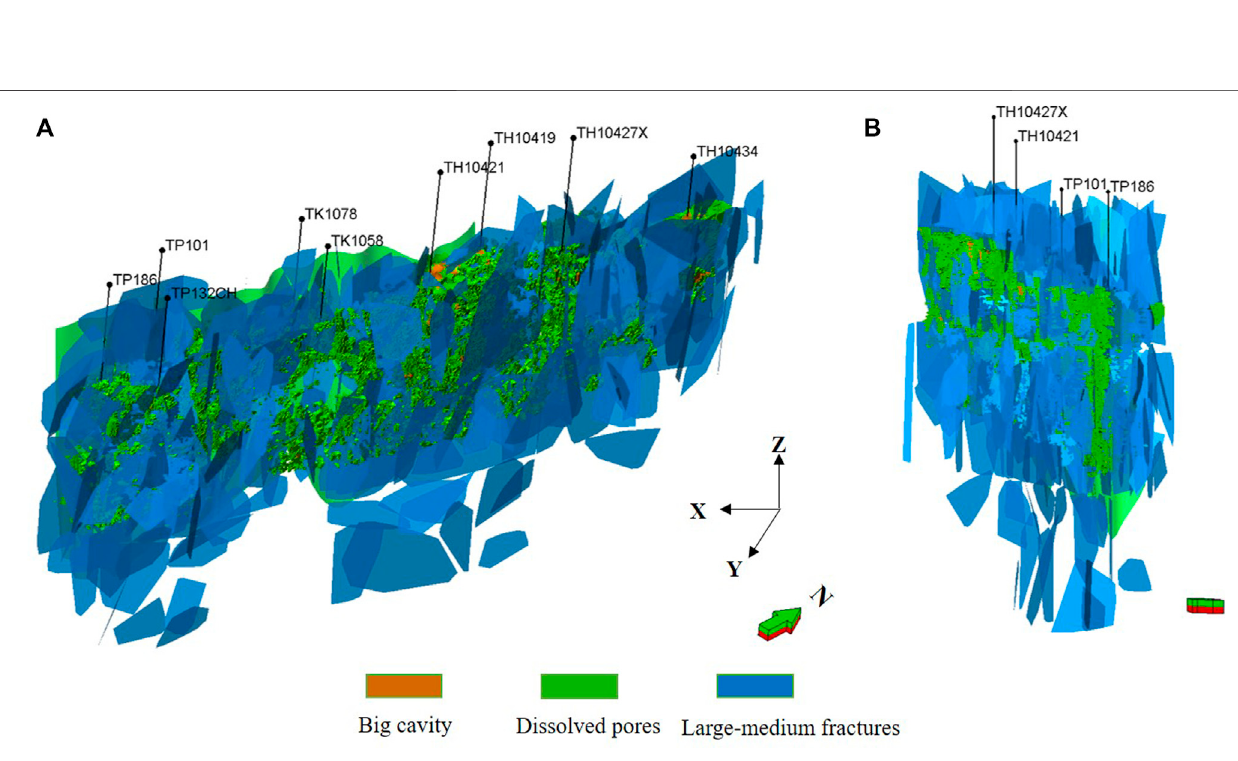
Frontiers in Earth Science |